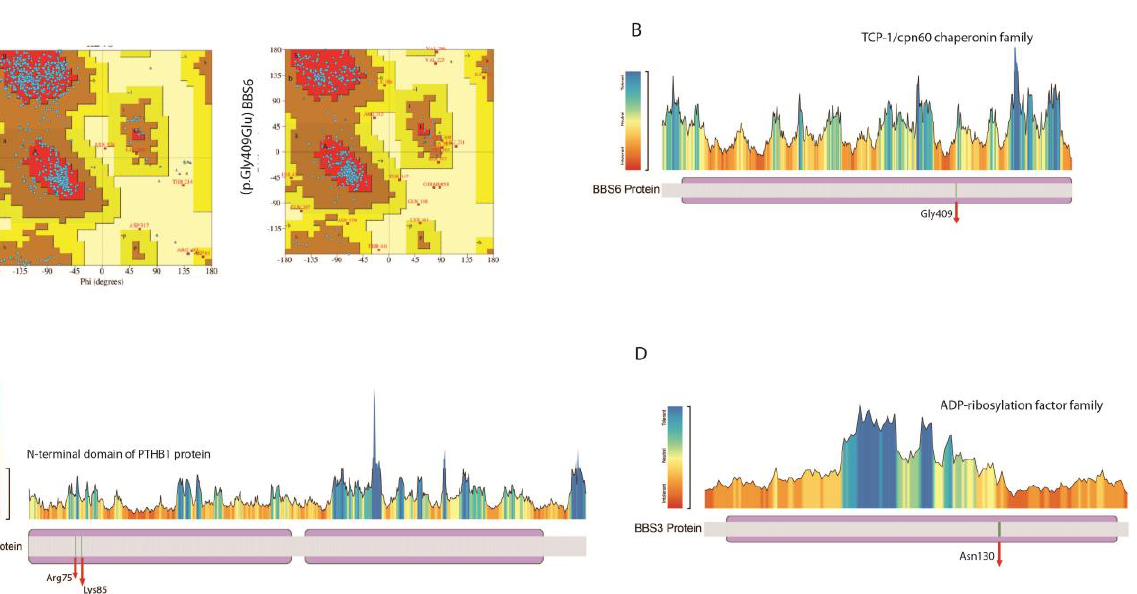
Figure 2. Bardet-Biedl Syndrome affected Pedigrees with novel variations showing chromatogram along with the wild type and mutant protein models.